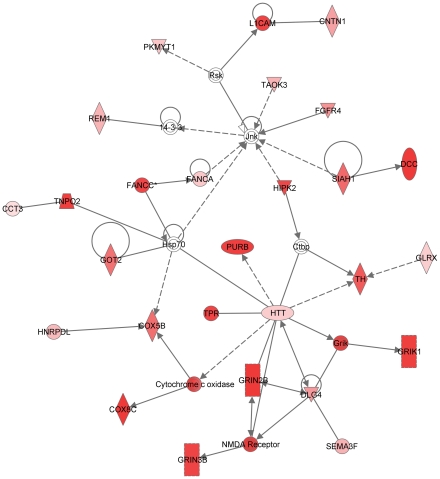
Network of genes involved in glutamate signaling in the prefrontal cortex of ethanol drinking mice.Network of genes involved in glutamate signaling generated through the use of Ingenuity Pathways Analysis (www.ingenuity.com). Genes significantly correlated to ethanol drinking are colored pink to red based on significance.